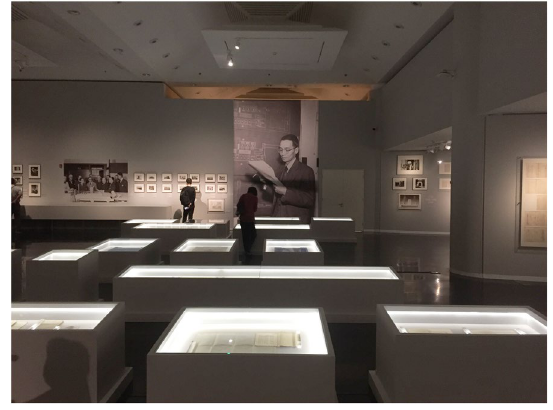
Fig. 2 Photo of the exhibit, including a giant photo of Liang Sicheng showing that he was involved in the design of the United Nations building (1947) and white display cases (Source: the author)